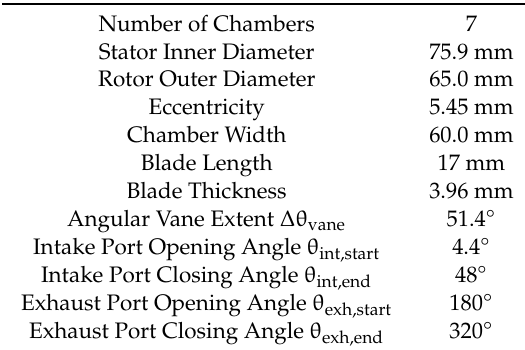
Figure 1. Main dimensions of the sliding rotary vane expander. Table 1. Sliding rotary vane expander geometry.